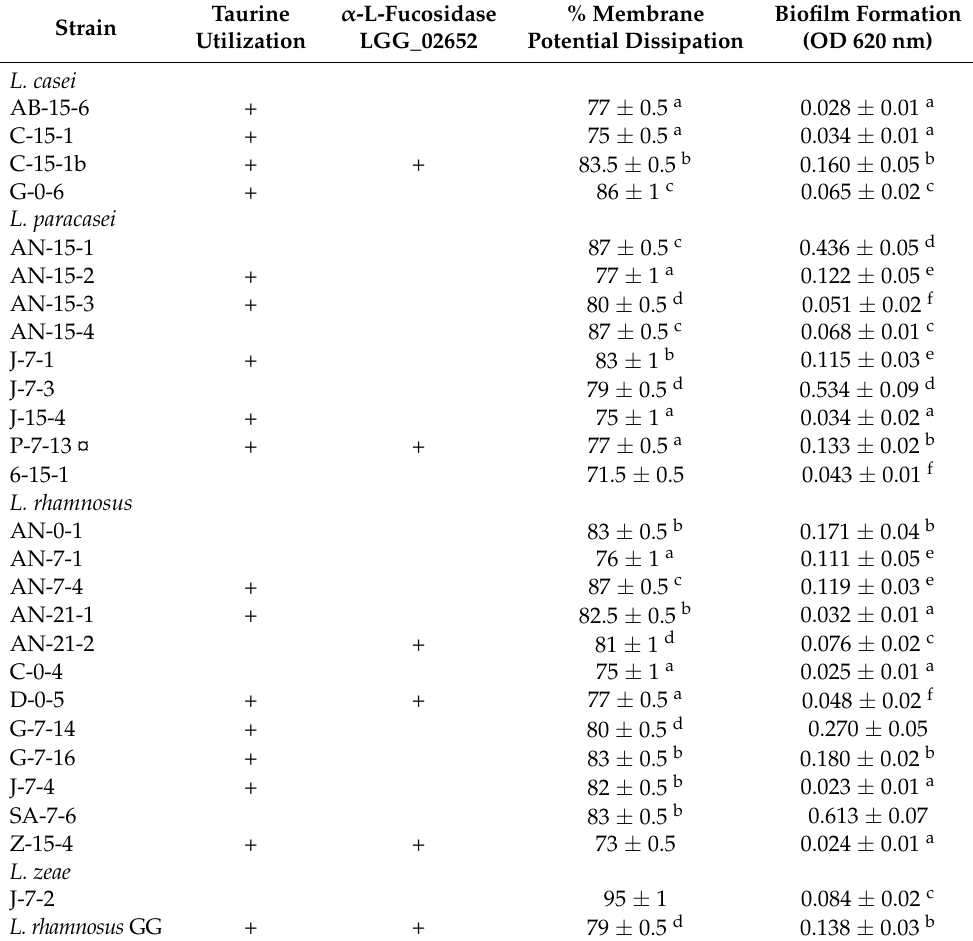
Table 2. Distribution of variable genes involved in survival in GIT in intestinal isolates of L. casei , L. paracasei , L. rhamnosus , and L. zeae , percent dissipation of membrane potential in presence of 1.5% bile salts and biofilm formation extent. Strain